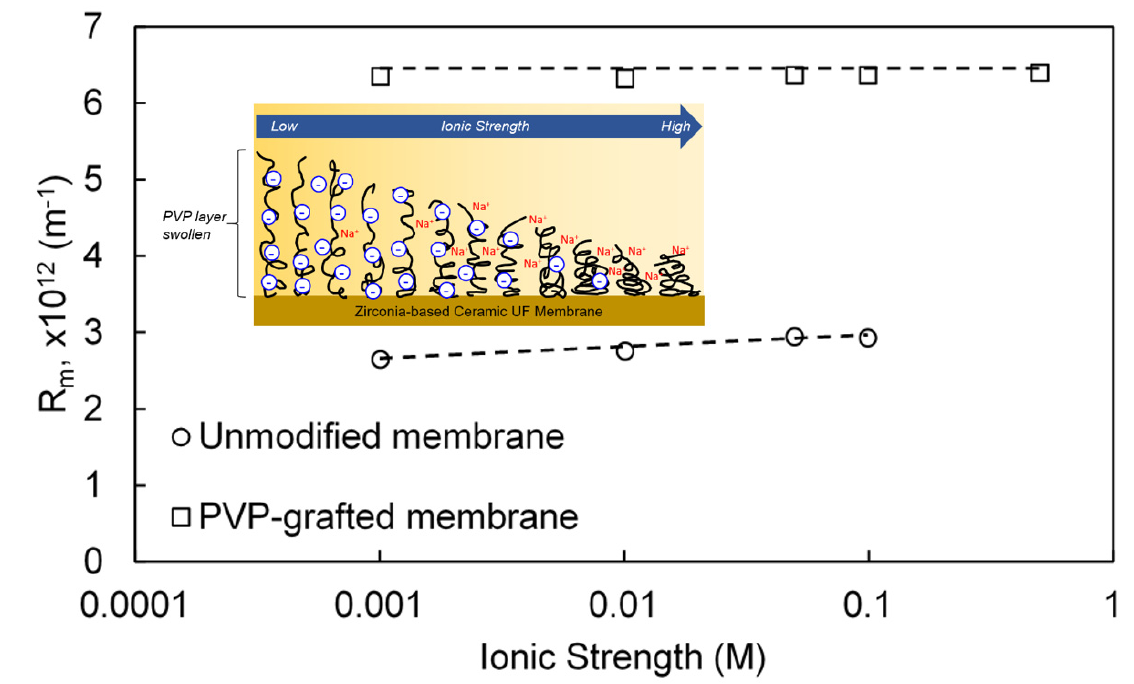
Figure 5. Effect of ionic strength on hydraulic resistance of unmodified and PVP-ZrO 2 membranes at pH of 7. (Inset figure is a depiction of the collapse of the progressive collapse of the tethered chains with increasing ionic strength which leads to the observed rise in membrane hydraulic resistance).